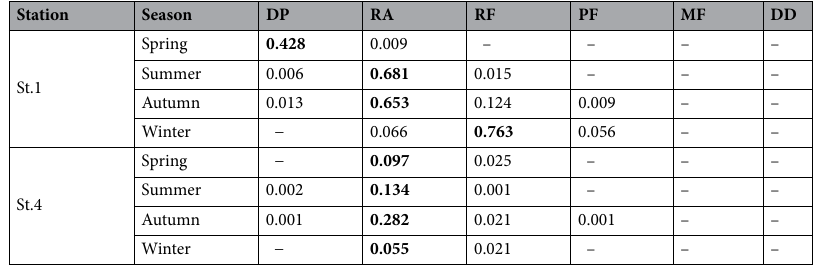
Table 3. Testing of niche apportionment models at St.1 and St.4 in different seasons. Best fitting values are in bold. The models are in order of increasing evenness from left to right (DP: Dominance Preemption, RA: Random Assortment, RF: Random Fraction, PF: Power Fraction, MF: MacArthur Fraction, DD: Dominance Decay). Symbol “−” means no fit to data ( p <